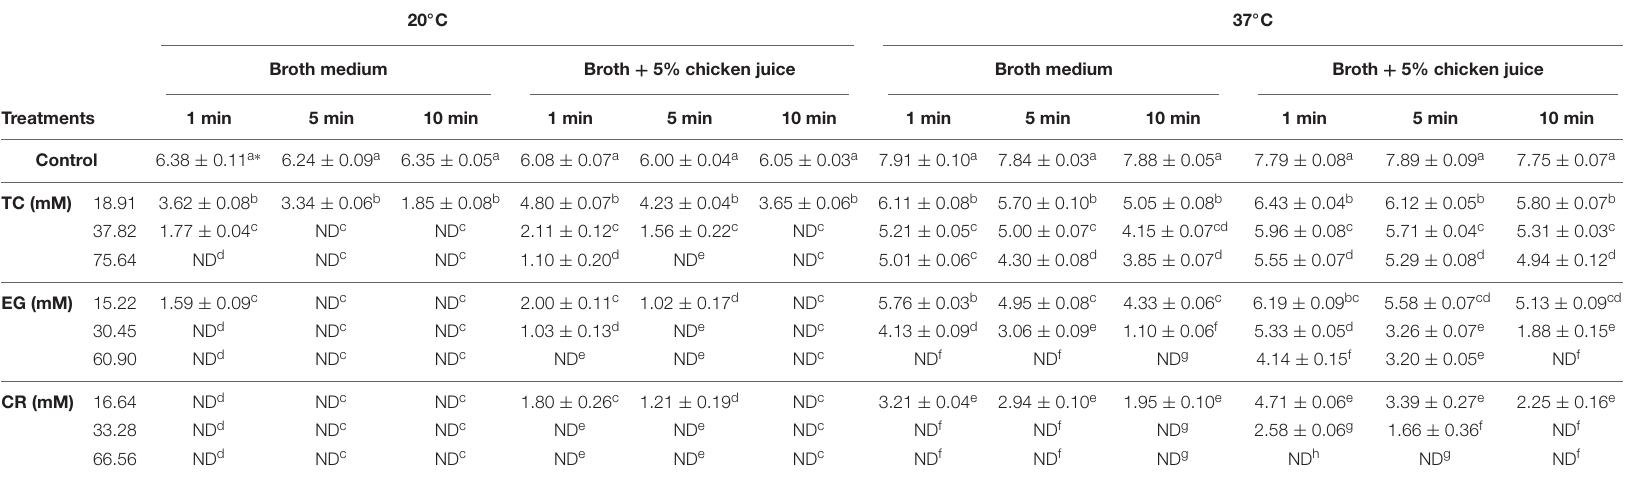
TABLE 3 | Effect of trans -cinnamaldehyde (TC; 18.91, 37.82, 75.64 mM), eugenol (EG; 15.22, 30.45, 60.90 mM), and carvacrol (CR; 16.64, 33.28, 66.56 mM) on mature Campylobacter jejuni NCTC 11168 biofilms formed on stainless-steel coupons at 20 ◦ C or 37 ◦ C in the broth medium and in the presence of chicken meat juice ( n =